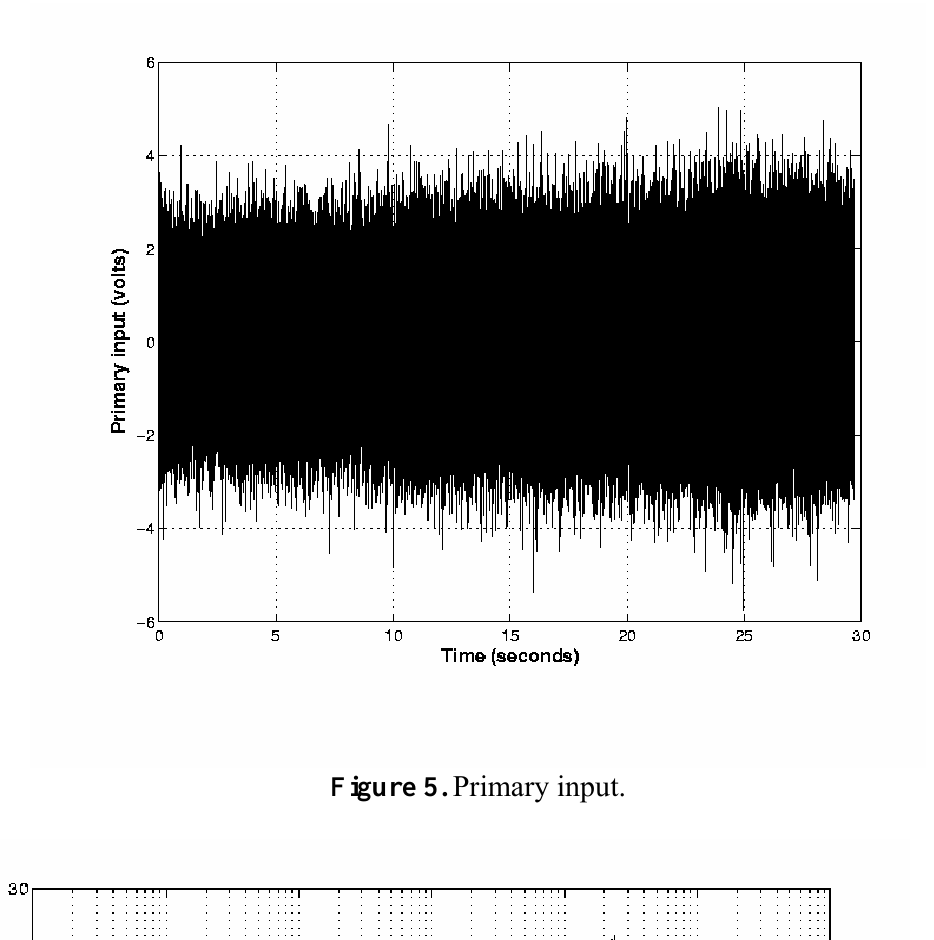
Figure 5. Primary input.